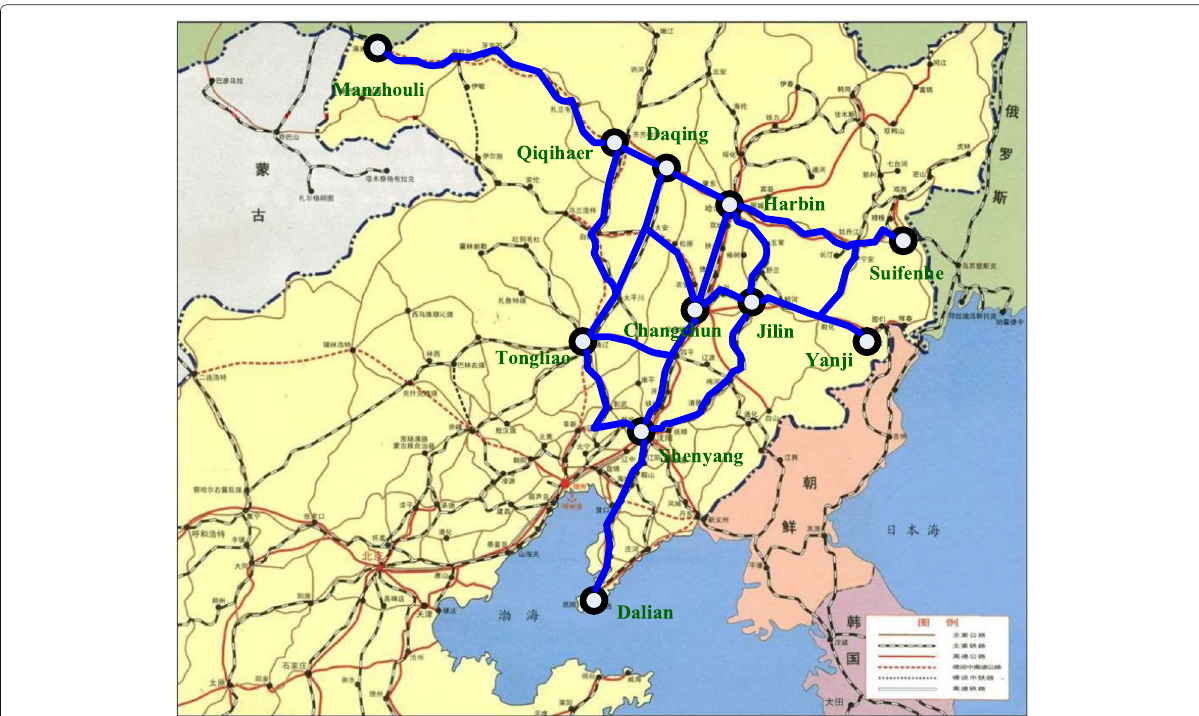
Fig. 2 Real transportation network of a transportation enterprise in Northeast